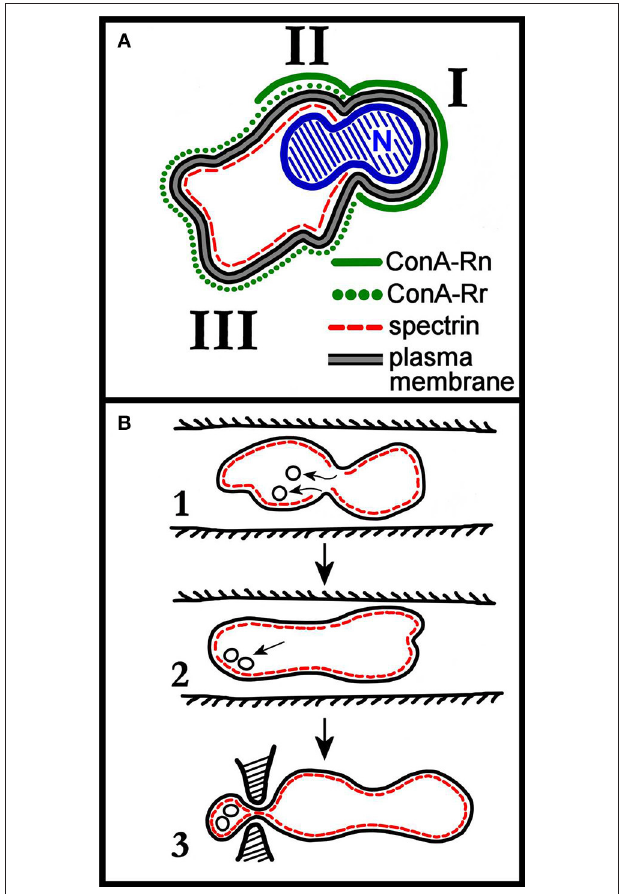
FIGURE 1 | (A) Schematic distribution of membrane proteins in the enucleating mouse erythroblast. Roman numerals I, II, and III correspond to the domains identified by the authors of the work ( Geiduschek and Singer, 1979). Domain III corresponds to the incipient reticulocyte. The nucleus (N), not completely extruded, shows the characteristic constriction which separates domain I from domain II. As discussed in the text of the cited work, two classes of ConA receptors (ConA is a lectin that binds to band3, so ConA receptors are band 3 molecules) are assumed to be present in the erythroblast membrane, with ConA-Rn (but not ConA-Rr) present in domain I; both ConA-Rn and ConA-Rr in the membrane of domain II; and ConA-Rr (but not ConA-Rn) in domain III. Most strikingly, spectrin is confined to domains II and III. Re-drawn from Geiduschek and Singer (1979). (B) Rudimentary early depiction of a model for the remodeling of the cell membrane during retic maturation to RBC in vivo . Panel 1 depicts the invaginations of spectrin-free domains of the retic membrane occurring in the circulation, and their subsequent endocytosis. In panel 2, the endocytosed vesicles are pictured as associating with the membrane either to fuse with it or to be exocytosed. In panel 3, the exocytosis of vesicles in a larger, spectrin-containing body is pictured as occurring by mediation of the spleen. Re-drawn from Zweig et al.